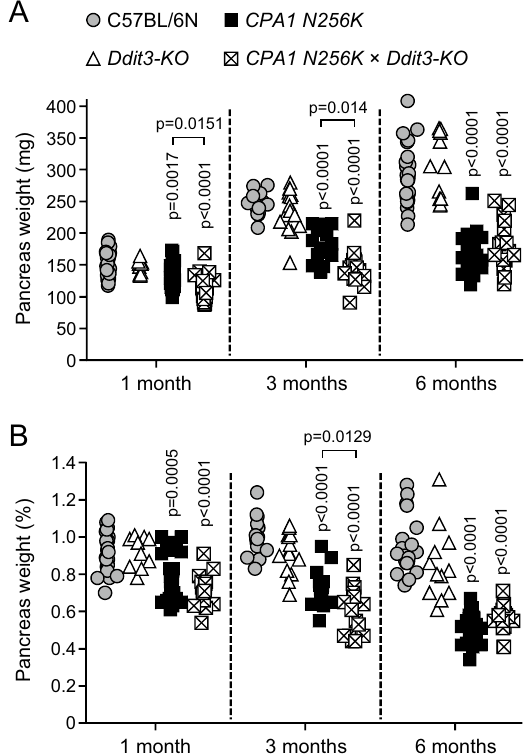
Figure 2. Pancreas weight in CPA1 N256K × Ddit3-KO mice. ( A ) Pancreas weight of mice at 1, 3, and 6 months of age. C57BL/6N (n = 23, 15, and 25), Ddit3-KO (n = 10, 17, and 12), CPA1 N256K (n = 25, 16, and 25), CPA1 N256K × Ddit3-KO (n = 18, 16, and 16). ( B ) Pancreas weight expressed as percent body weight. Individual data points are